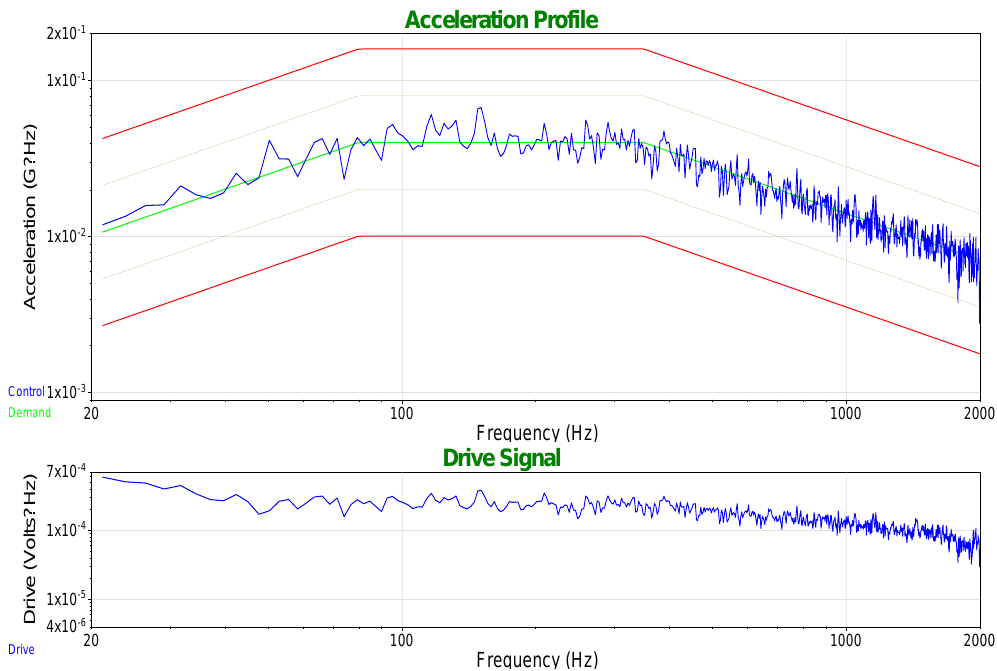
Figure 12. The profile of the random vibration used for testing.